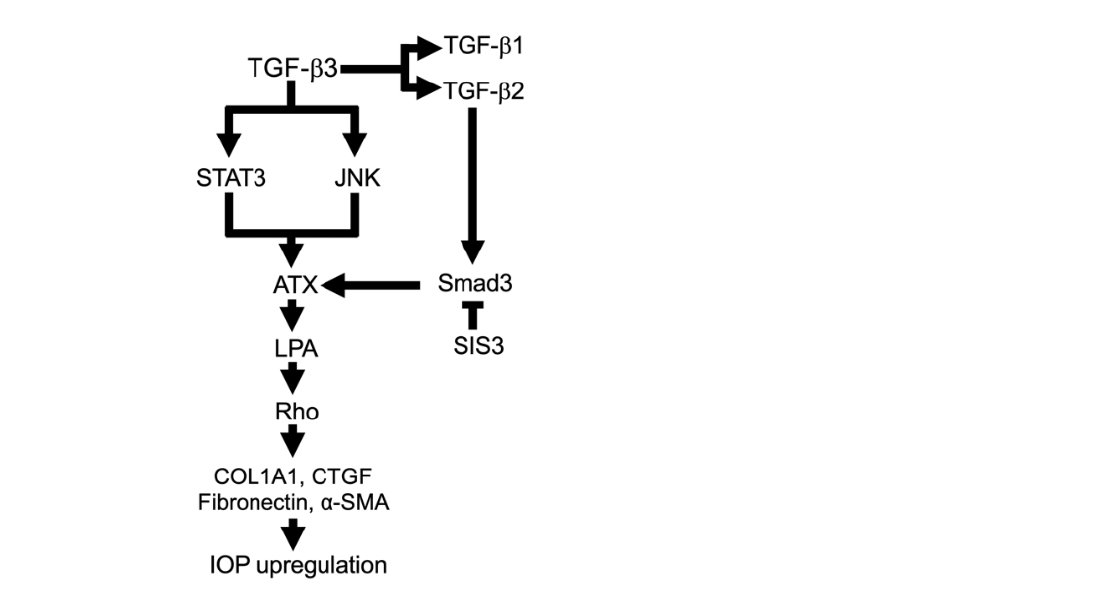
Figure 8. Potential mechanisms of TGF- β 3-mediated ATX expression and fibrotic changes in HTM cells. ATX expression and fibrotic changes appeared to be partially mediated by the canonical pathway, as well as the noncanonical pathway.